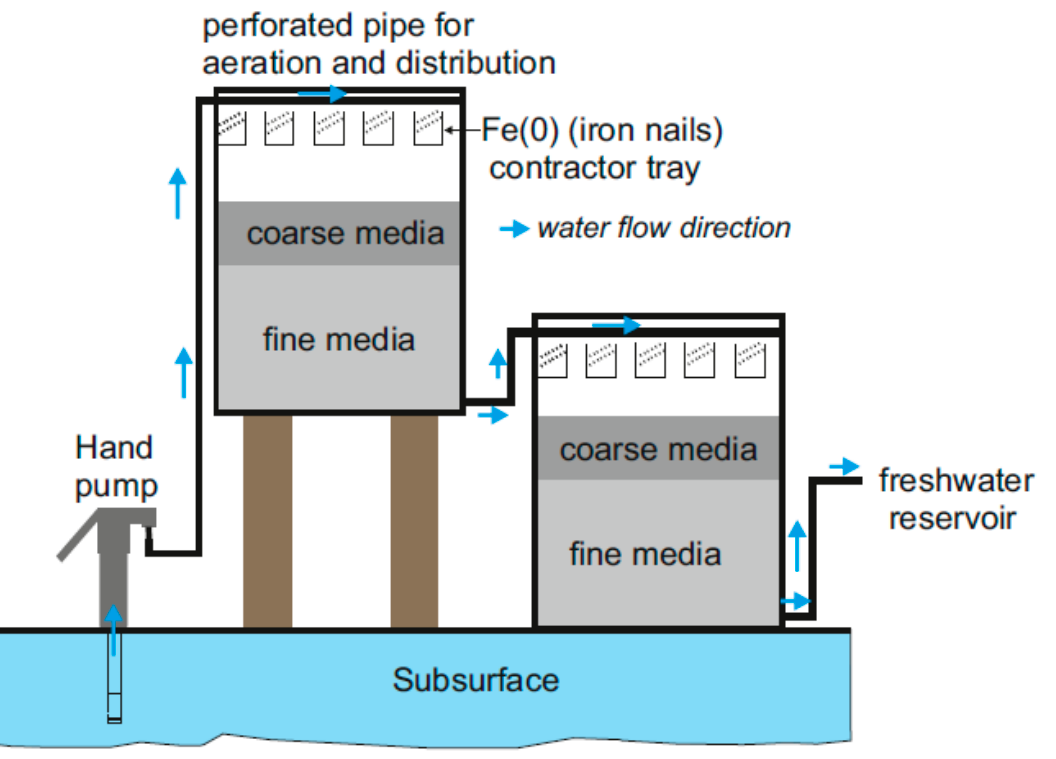
Figure 3. Conceptual sketch of the Indian Institute of Technology Bombay (IITB) filter (adapted from Etmannski [61]).